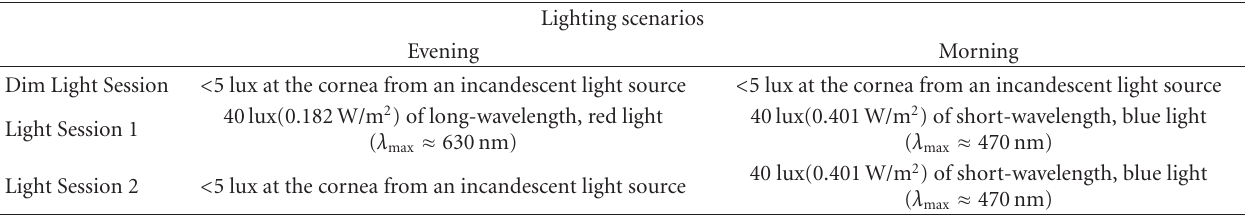
Table 2: Lighting scenarios presented to all 18 participants in a counterbalanced manner. Lighting